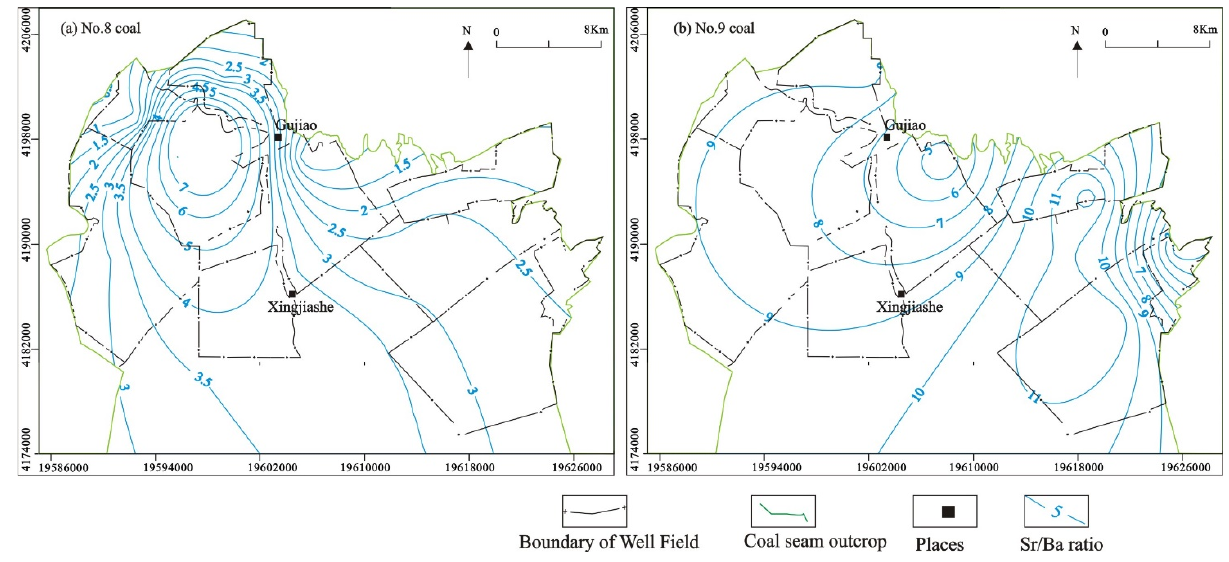
Figure 12. Sr/Ba ratio distribution of coal seams.